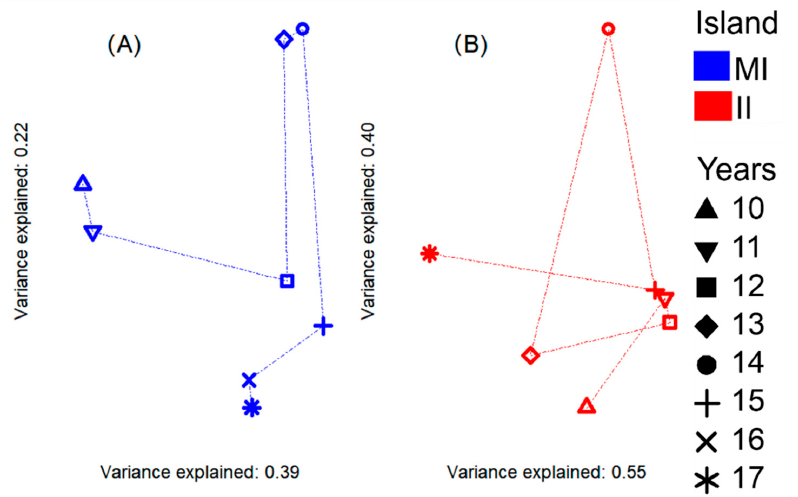
Figure 4. PCoA constructed from a Bray–Curtis similarity matrix representing the successional trajectories of the communities over the years. Each point represents the similarity between the mean value of the community biomass. ( A ) Marietas Islands, ( B ) Isabel Island.